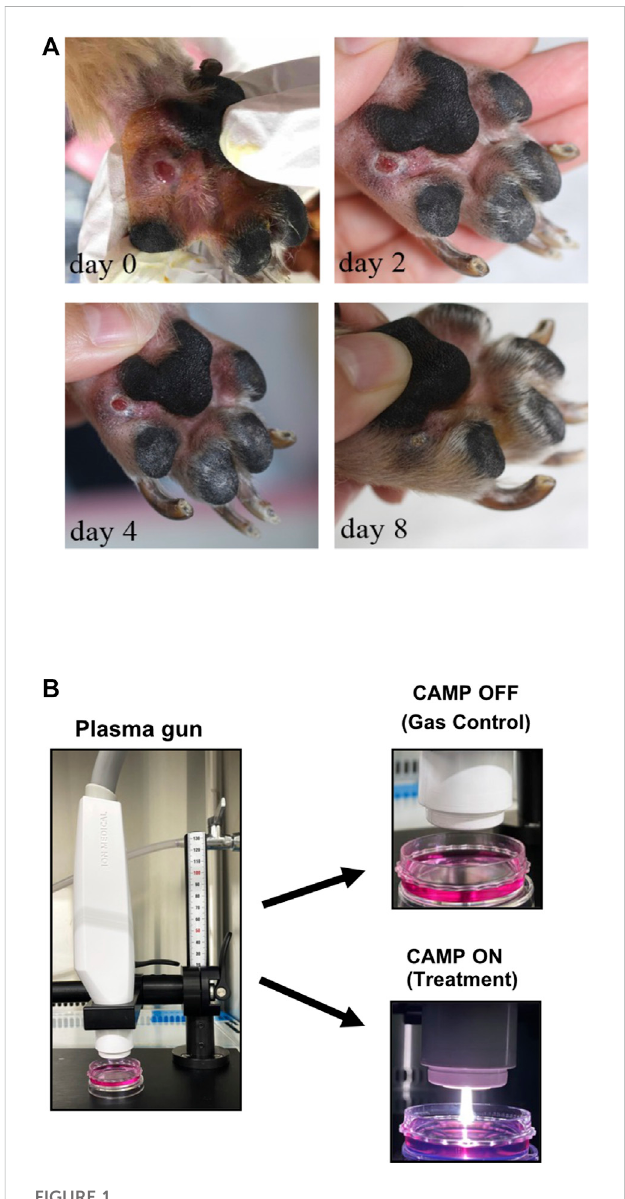
FIGURE 1 (A) Preliminary data of CAMP affecting the acceleration rate of wound healing in a 7-year-old Yorkshire Terrier. CAMP was adjusted to 30 W, and the fl ow rate of the argon gas was 15 L/min. CAMP was conducted on days 0, 2, 4, and 8. Each day, the procedure was applied to the lesion for 3 minutes. (B) Pictures of the CAMP device used in this